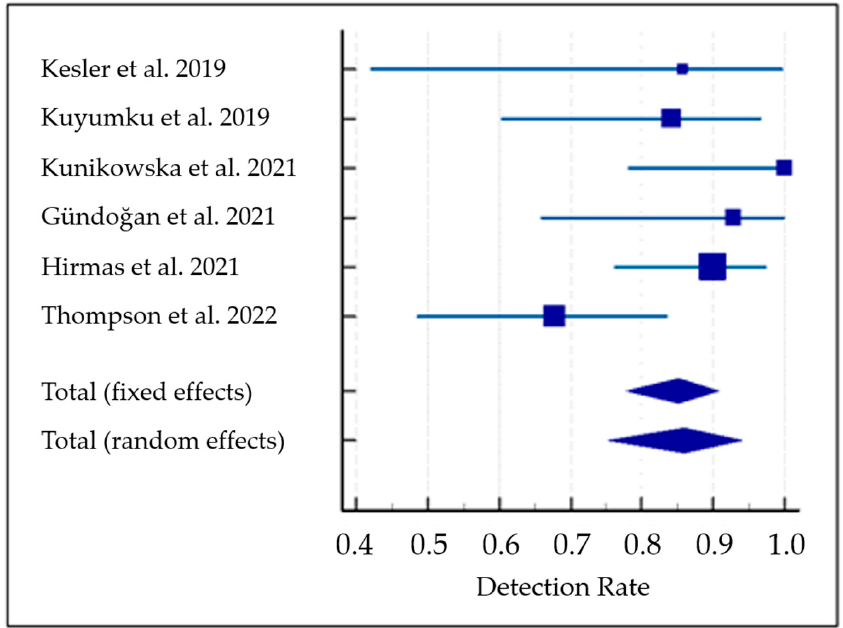
Figure 3. Meta-analysis on the detection rate of PET with PSMA-targeting radioligands in patients with hepatocellular carcinoma [28–33]. Blue lines indicate the 95% confidence interval values and blue squares indicate the detection rate value of each study. Trapezoid indicates the pooled value with 95% confidence interval values.